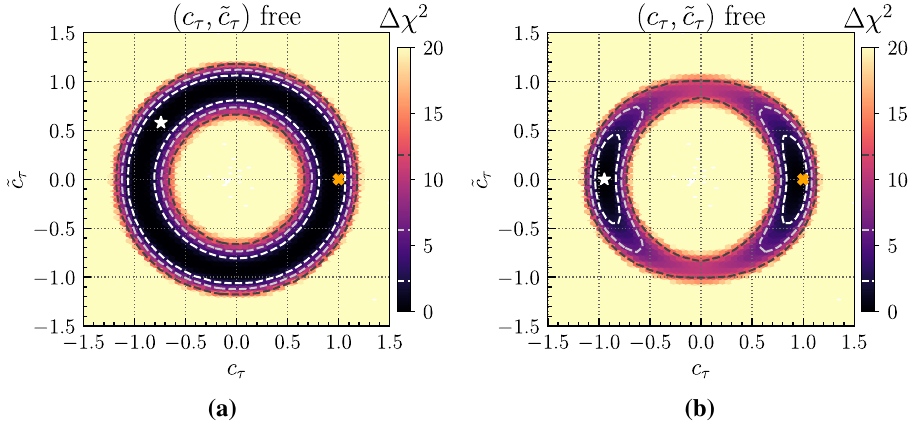
Fig. 2 1-flavor model ( τ ): results of fits to the LHC measurements in the ( c τ , ˜ c τ ) parameter plane where in the set of input measurements the CMS H → τ + τ − CP result [15] is ( a ) omitted and ( b ) included. The coupling modifiers c τ and ˜ c τ are treated as free parameters while all other parameters are fixed to their SM values. The color corresponds